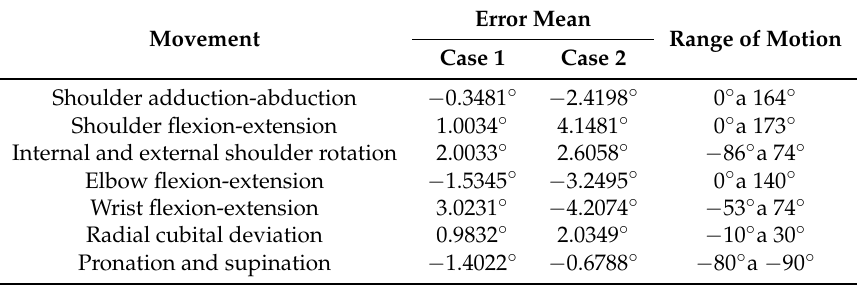
Table 2. Error in track tracking of the